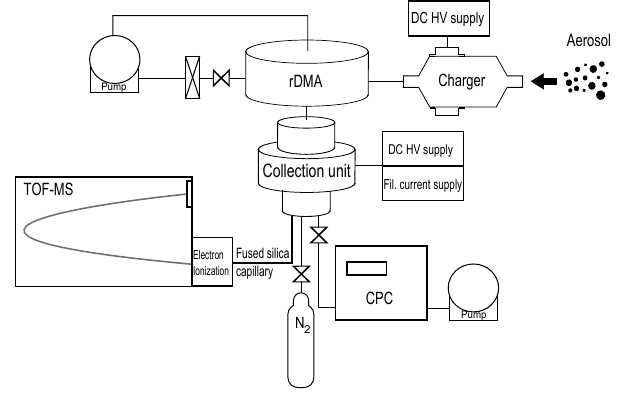
Fig. 1. Sketch of the instrument setup, with particle charging unit, radial differential mobility analyzer (rDMA), collection and desorp- tion unit and electron ionization time of flight mass spectrometer